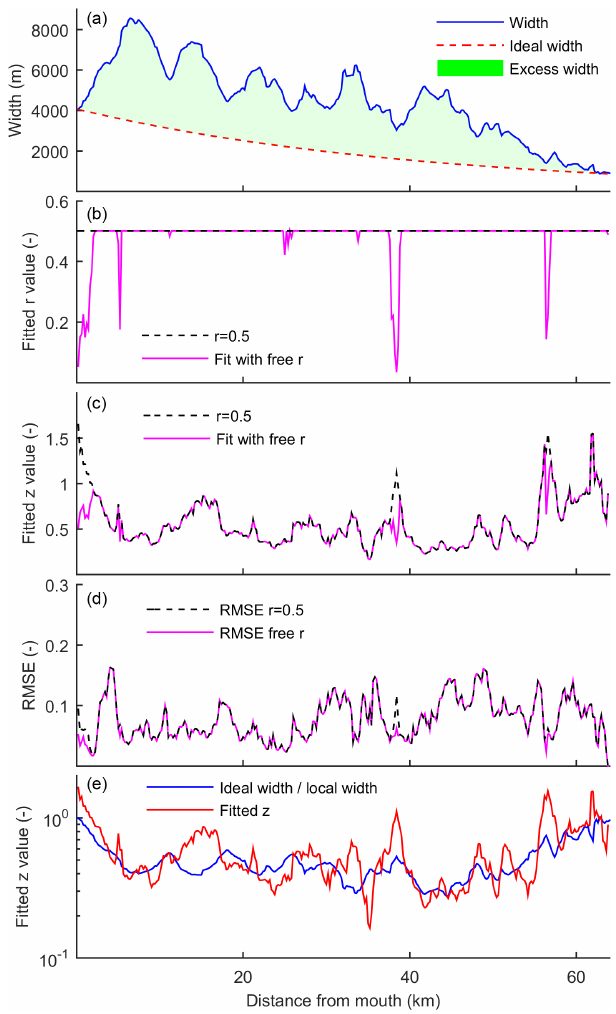
Figure 4. (a) Width along the Western Scheldt, with the maxi- mum ideal converging width profile indicated. The green area is defined as the excess width cf. Leuven et al. (2018a). For each along-channel transect of the estuary, the optimal fit of z and r in the Strahler (1952) function (Fig. 2, Eq. 1) was determined. (b, c) Results for the Western Scheldt when both z and r are freely fitted (solid line) and the results when r is fixed to a constant value of 0.5 (dashed line). (d) The quality of the fits remains about the same when r is set to a fixed value of 0.5 as indicated by the root mean square error (RMSE). (e) Fitted z values show similar trends as the ideal width divided by local